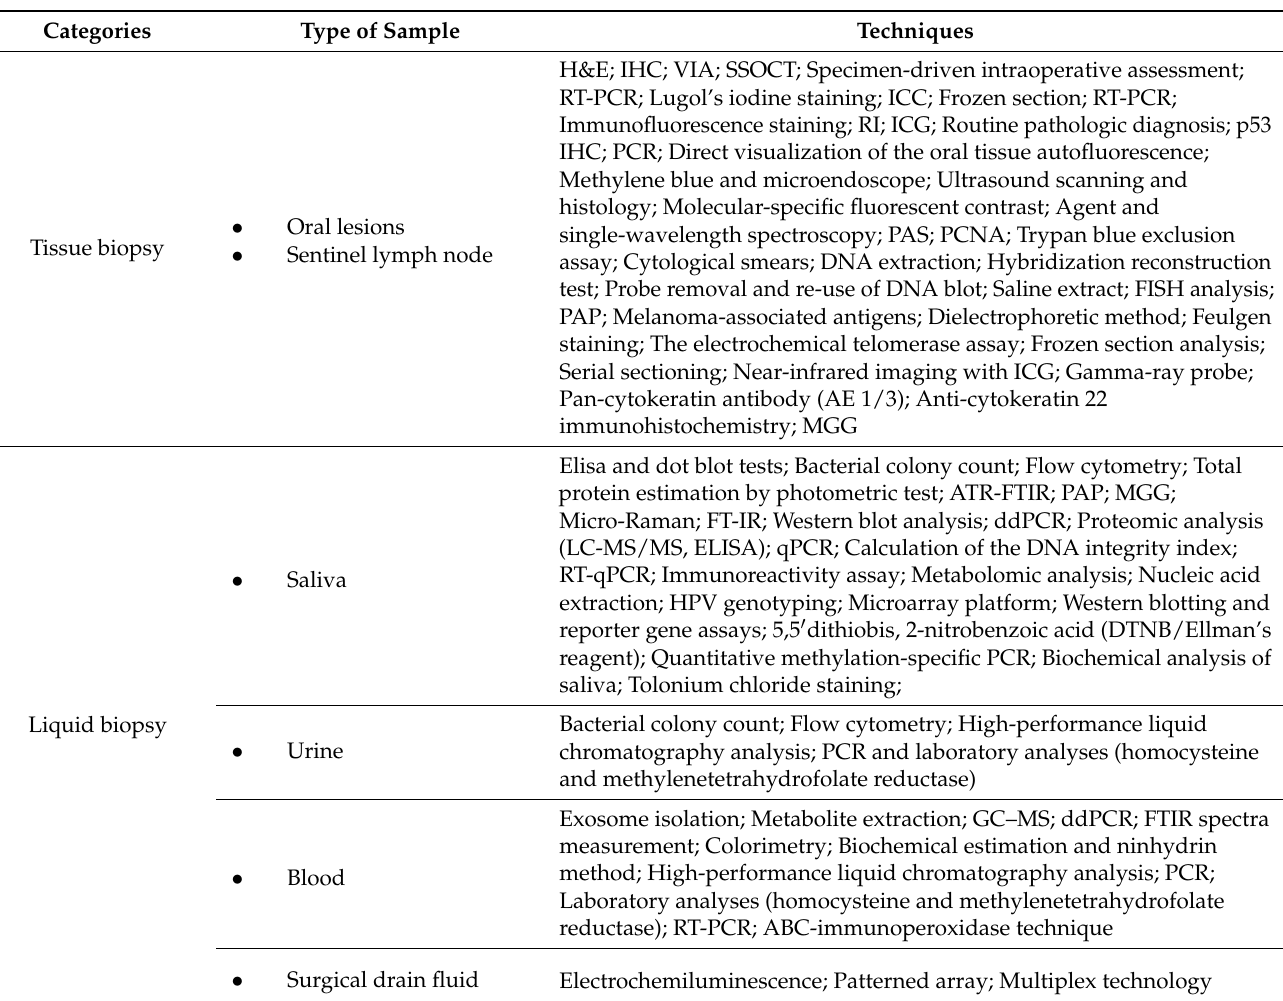
Table 2. Summary of downstream applications of oral cancer biopsy methods included in the